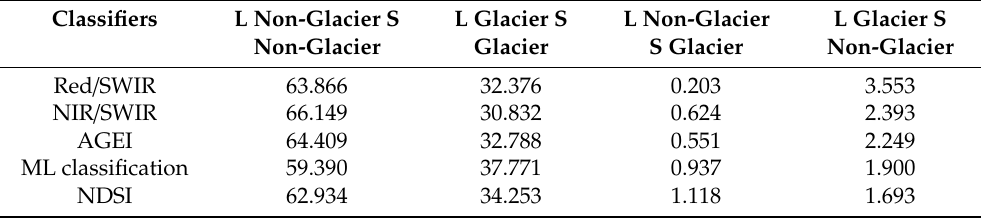
Table 4. Percentage of each type of pixels in the overlaid glacier distribution map.